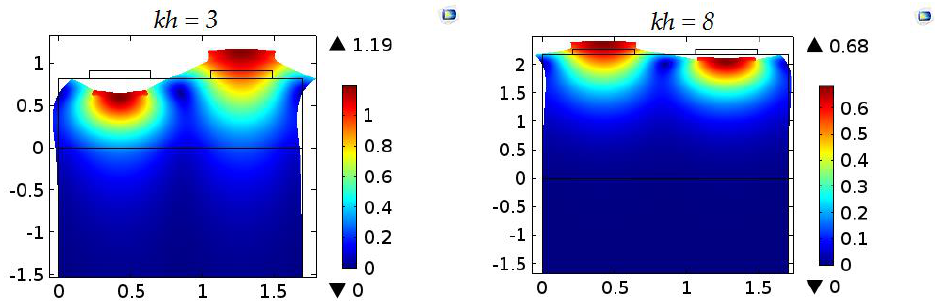
Figure 4. Modeling of Rayleigh wave confinement, view for kh = 3 and kh = 8. Figure 4 . Modeling of Rayleigh wave confinement, view for kh = 3 and kh = 8.